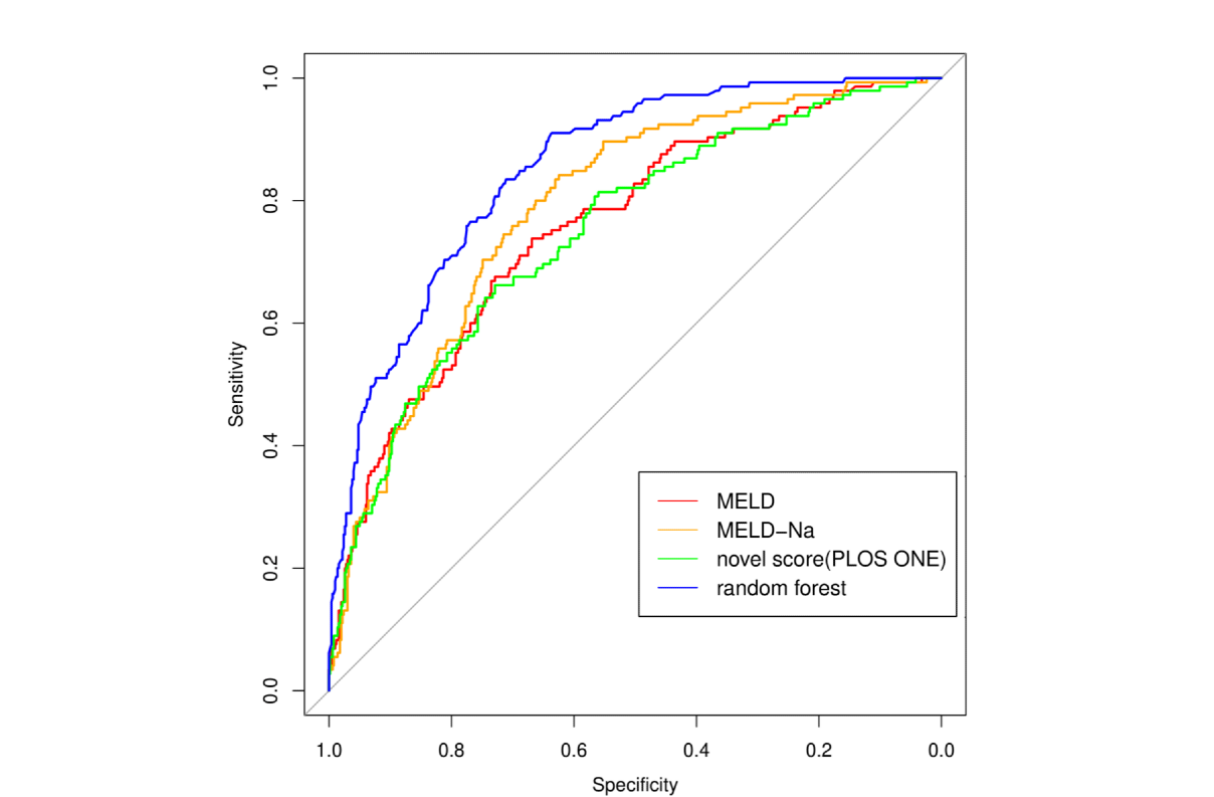
Figure 5. Receiver operator characteristic (ROC) curves with area under the curve (AUC) statistics of random forest, model for end-stage liver disease (MELD) score, MELD-NA score, and novel score.